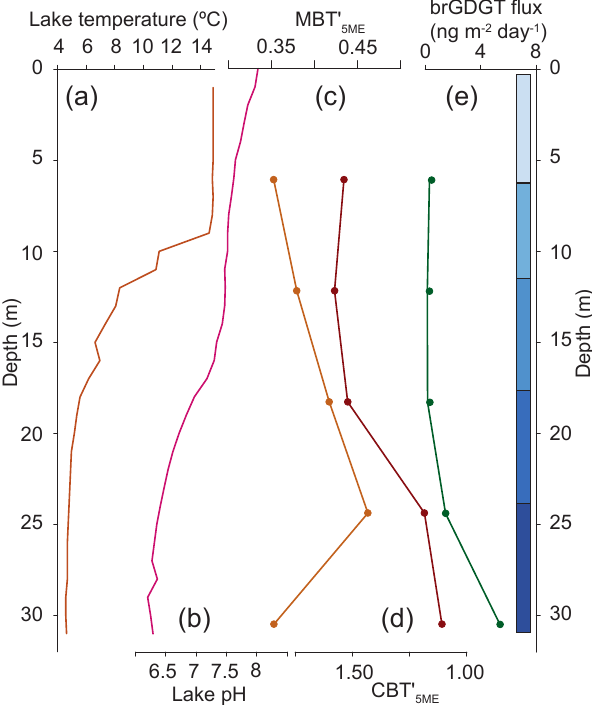
Figure 4. Hydrolab-measured temperature and pH profiles for Basin Pond compared with flux-weighted average brGDGT-based reconstructions. (a) Fall lake temperature profile, showing the mixed layer extending to ∼ 9m in water depth, followed by the thermocline (9–15m) and a cold deep layer (15–32m). (b) Fall pH profile. The pH ranges from ∼ 7 . 5 at the surface to ∼ 6 . 2 at depth. (c) Flux-weighted average MBT values measured at sediment traps. (d) Flux-weighted average CBT values measured at sediment traps. (e) The brGDGT fluxes measured at sediment traps. Blue bars cor- respond to the depth ranges in in Fig.